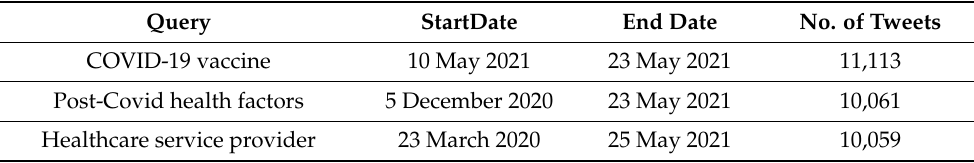
Table 3. Collected twitter data